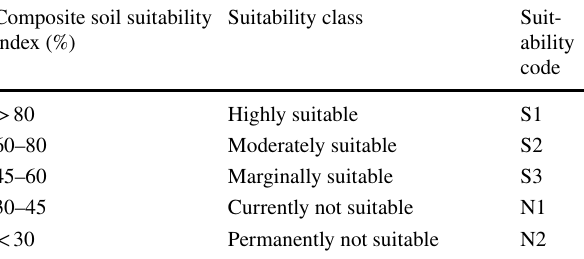
Table 3 Suitability classification of the composite soil index Composite soil suitability index